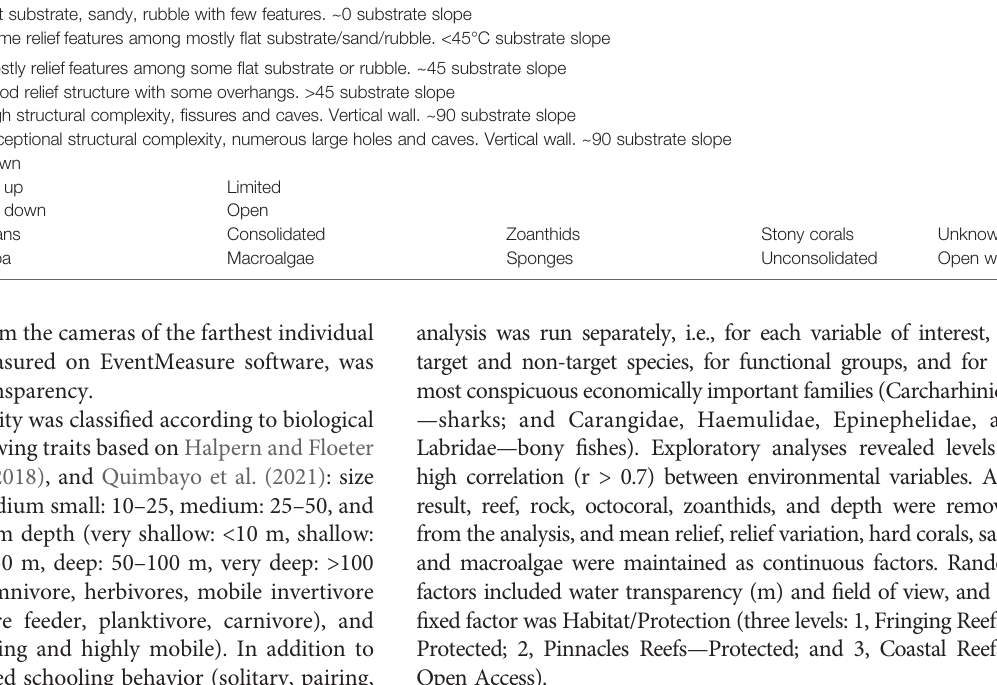
TABLE 1 | Habitat classi fi cation based on broad CATAMI Classi fi cation scheme in Althaus et al. (2015) and Wilson et al. (2007).